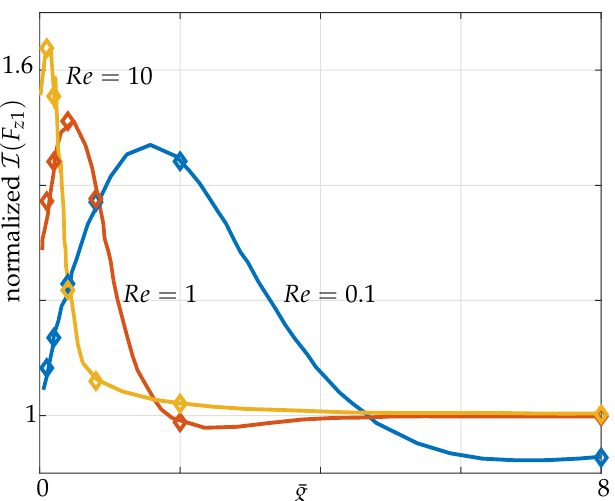
Figure 5. Variation of the imaginary part of nondimensional hydrodynamic force across microbeam 1 for two beams vibrating in-phase (1–1 configuration) over ¯ g normalized by their corresponding values at the same Re in an unbounded fluid with solid lines representing Basak’s results and markers our validation against